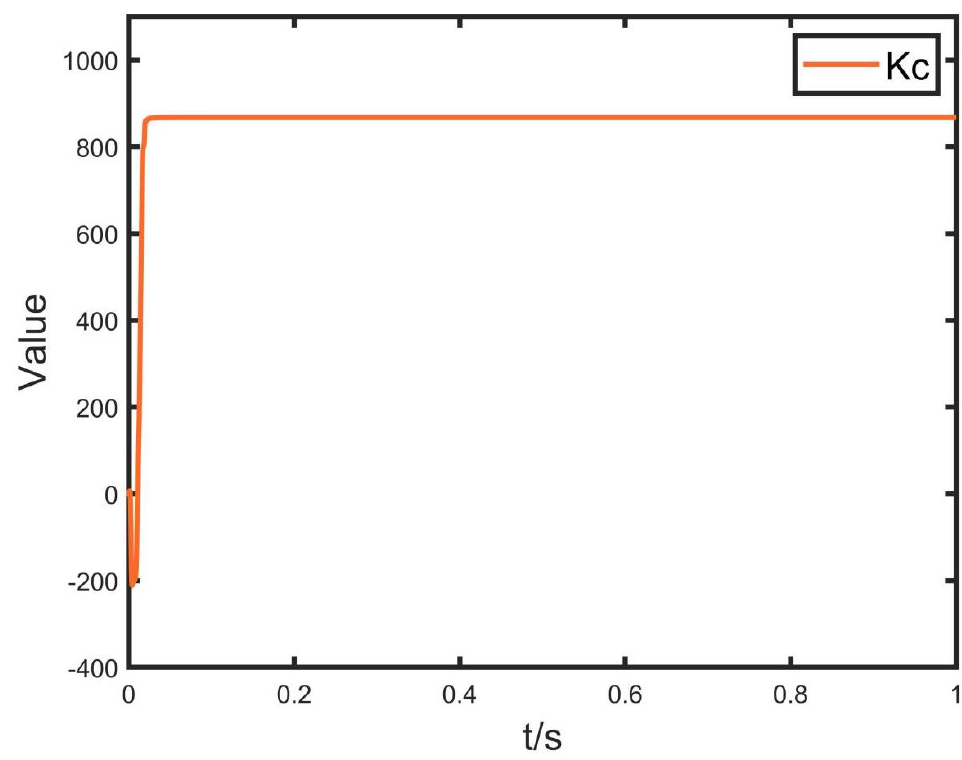
Figure 11. Output power of PV array under local shadows.